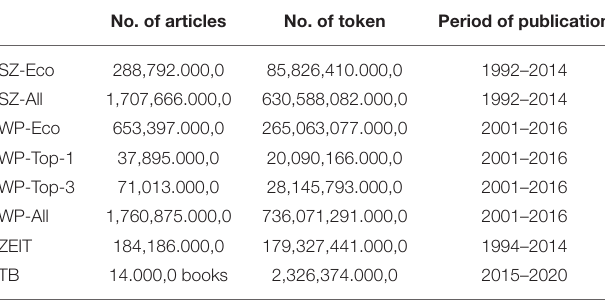
TABLE 1 | Summary of corpora used in the study. No. of